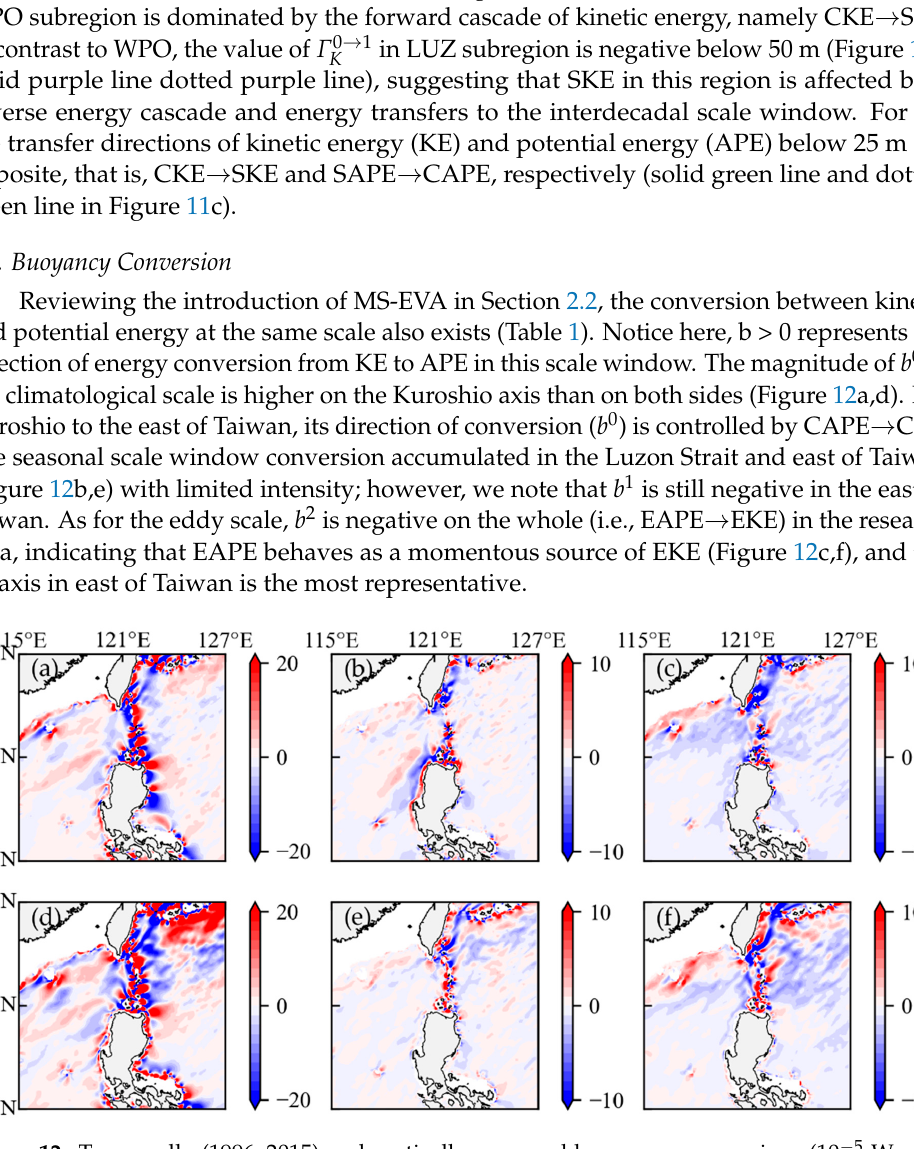
Figure 12. Temporally (1996–2015) and vertically averaged buoyancy conversions (10 − 5 Wm − 3 ). ( a ) b 0 upper than 266 m; ( b ) b 1 upper than 266 m; ( c ) b 2 upper than 266 m; ( d ) b 0 lower than 266 m; ( e ) b 1 lower than 266 m; ( f ) b 2 lower than 266